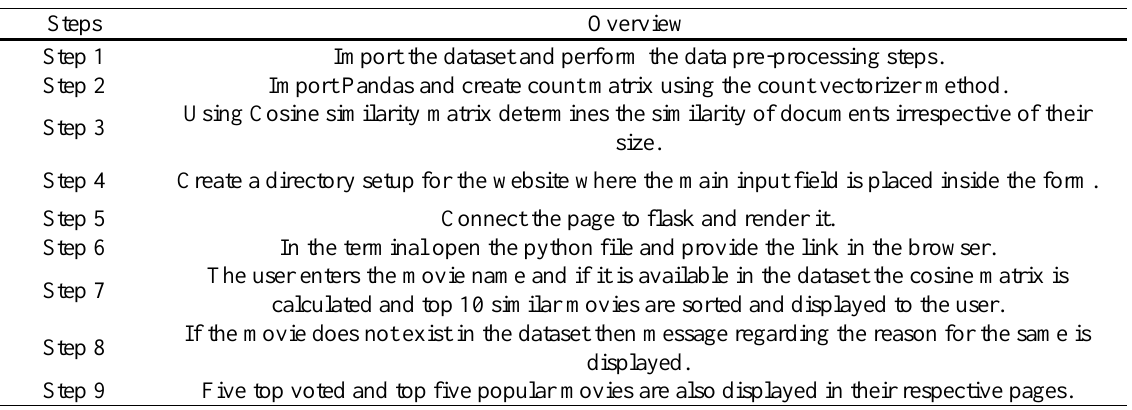
Table 5. Pseudo code movie recommendation system.